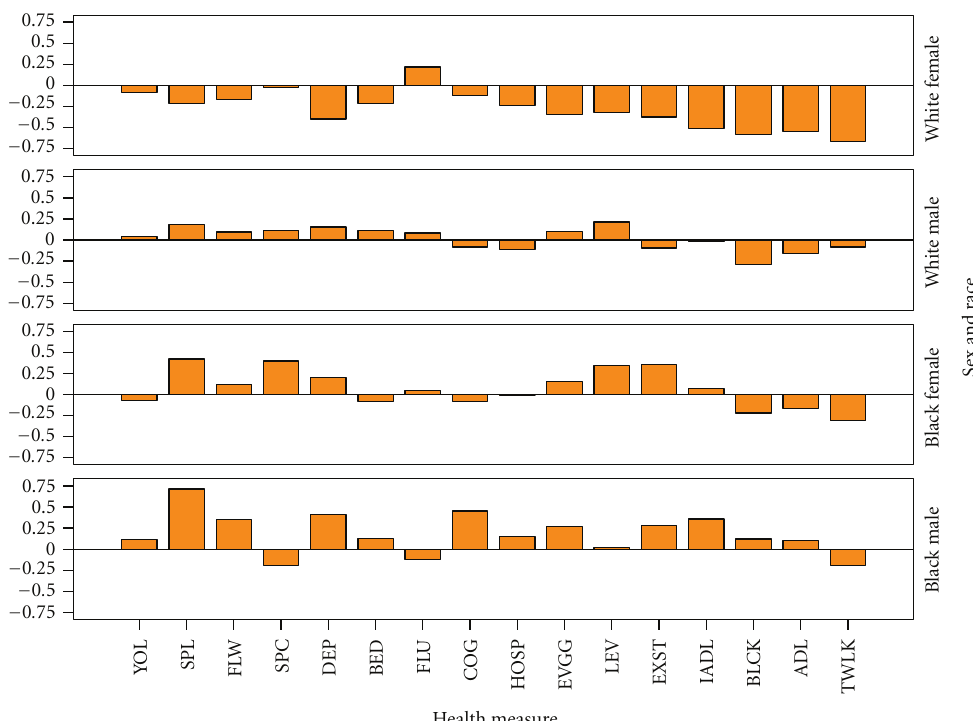
Figure 2: Adjusted di ff erence in YHL (Overweight WC − Normal